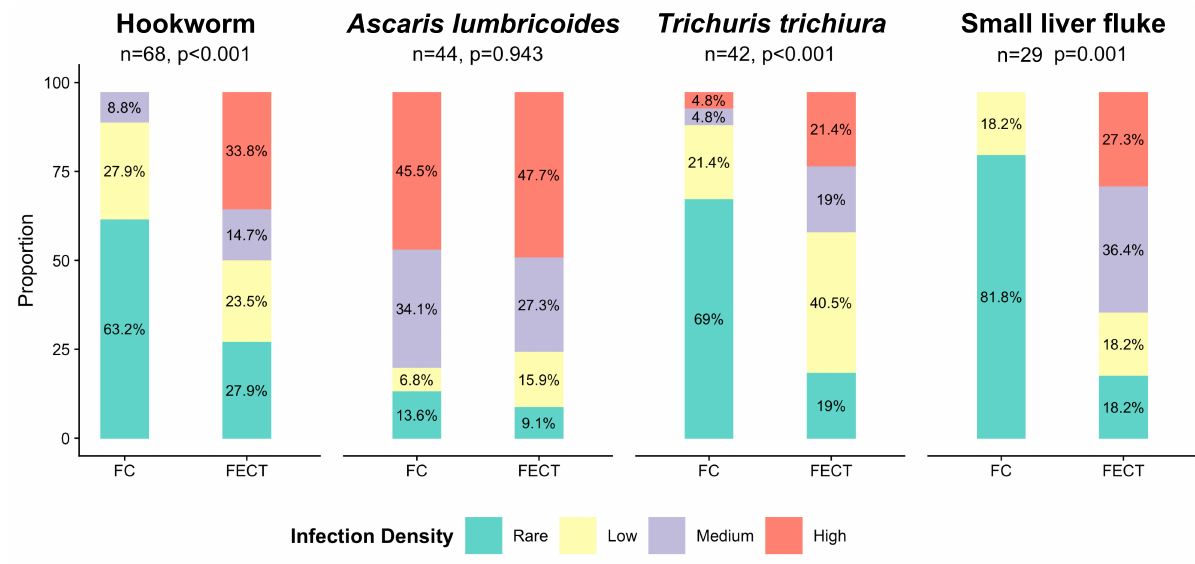
Figure 2. Helminth species-specific infection intensity compared between samples on which both methods agreed on